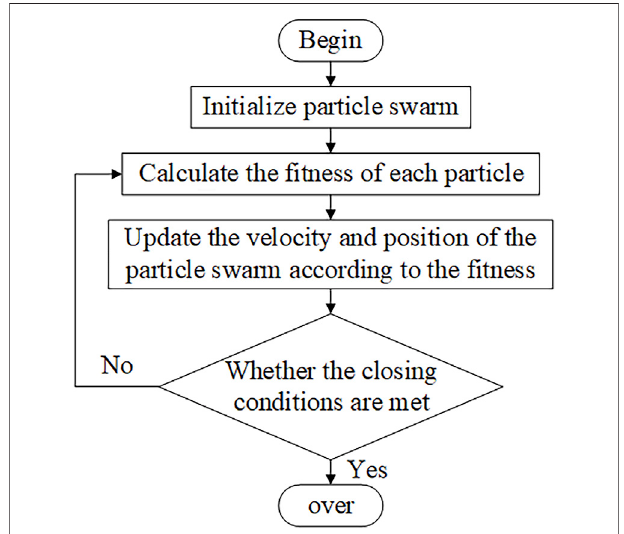
FIGURE 4 | Flow chart of particle swarm optimization.